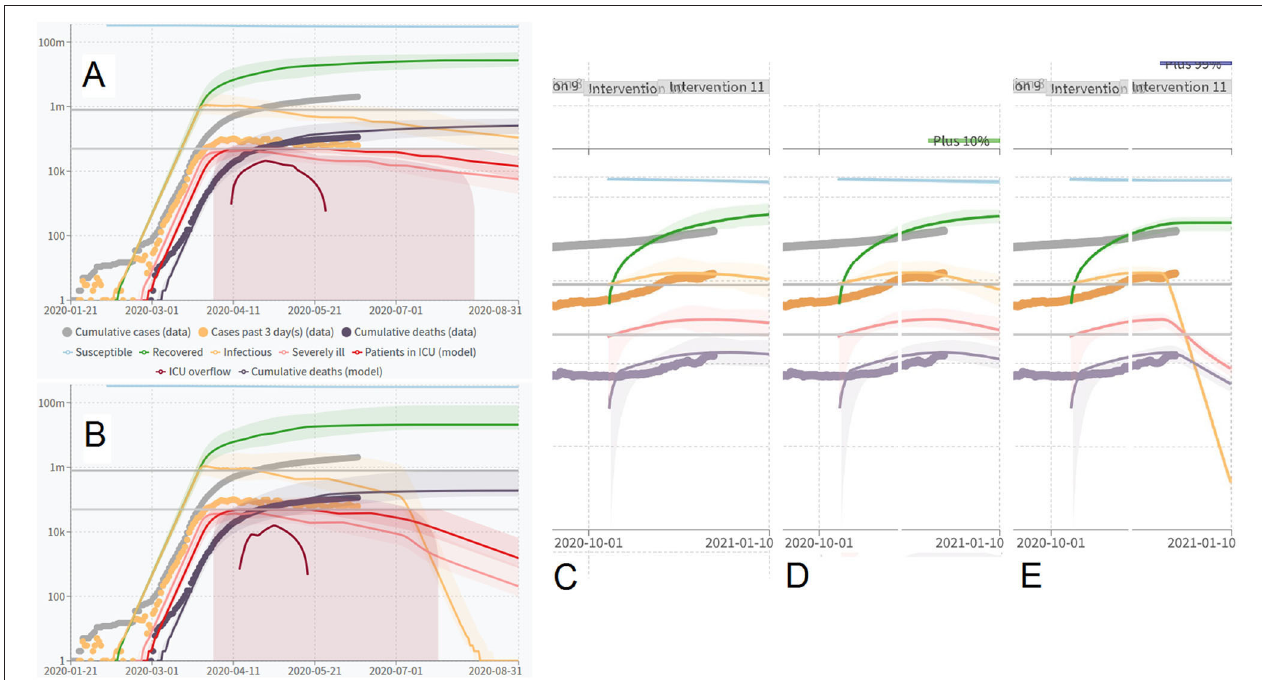
FIGURE 6 | Effects of late mask interventions on the number of active COVID-19 cases. (A) Full defaults according to COVID-19 Scenarios. (B) Full defaults with late mask intervention using advanced mask (99.9991% two-mask protection). (C–E) show the effects of interventions beginning on December 1, 2020: (C) , full defaults; (D) , the effect of an added 10% protection, and (E) , the effect of an added 99% protection intended to approximate the effect of population-wide wearing of SCBA devices.